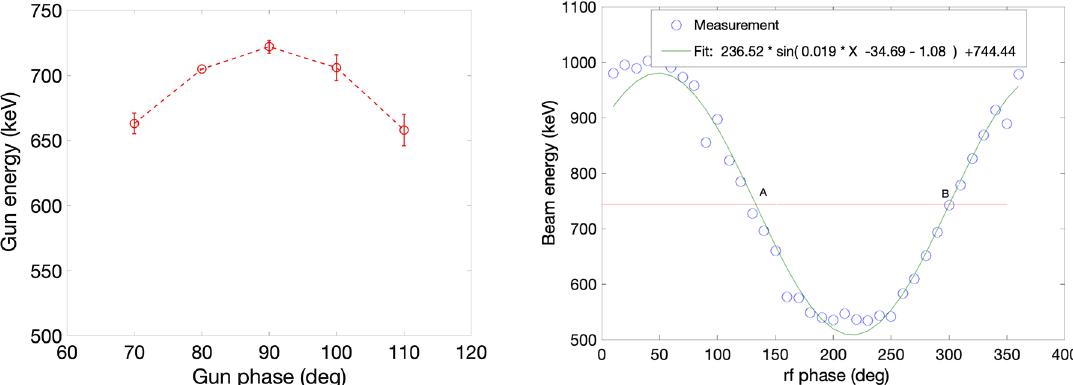
FIG. 6. Left: measured gun energy versus gun rf phase. Right: energy scan versus buncher rf phase. Points A and B are the buncher zero-crossing